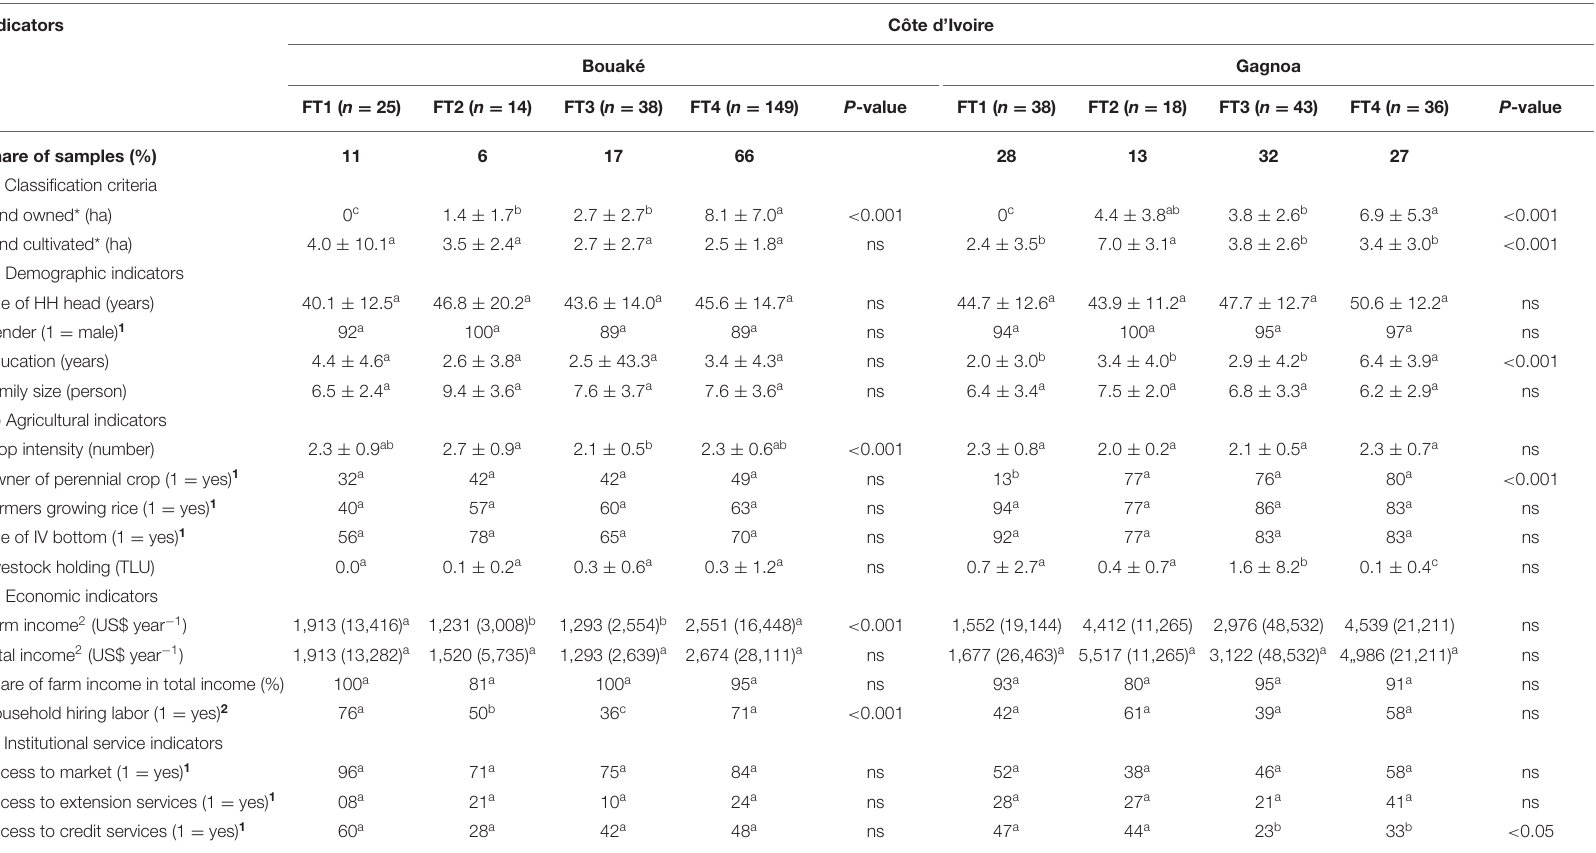
TABLE 5 | Farm household indicators (proportion and means ± standard of deviation) for the four farm types in selected regions of Côte d’Ivoire, based on the RHoMIS household baseline survey (2018–2019). Indicators Côte d’Ivoire Bouaké